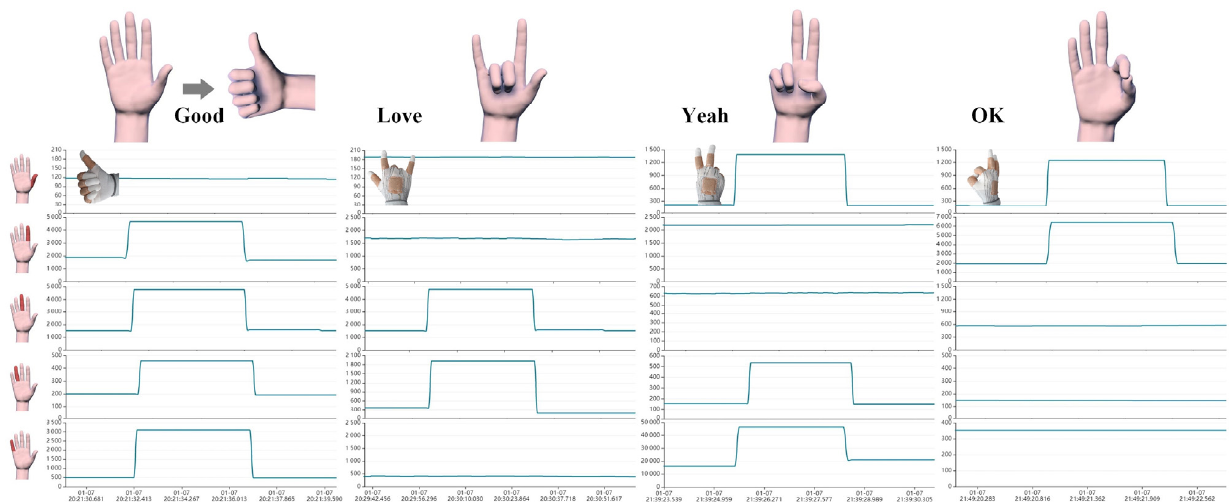
Figure 8. Demonstration of practical application: gesture recognition.